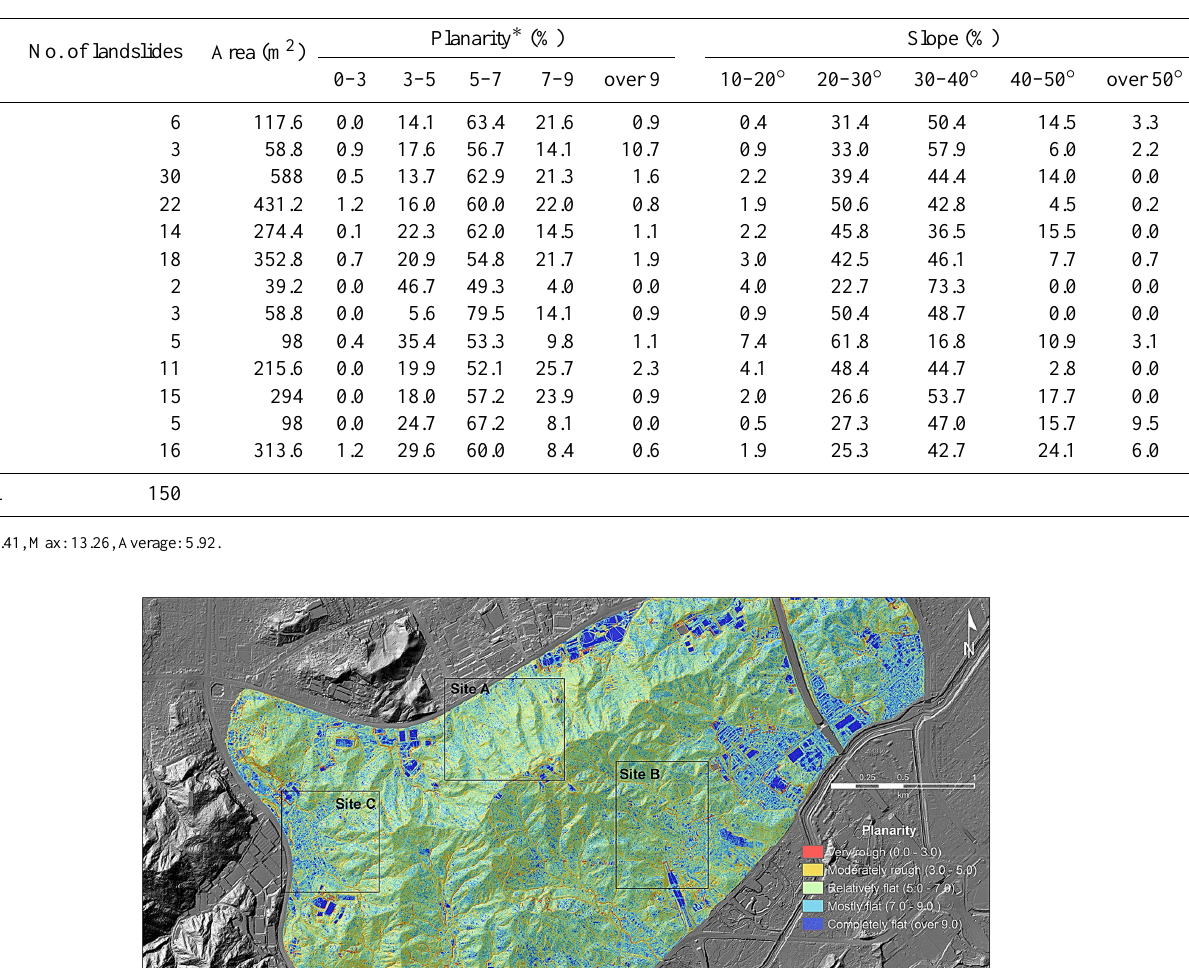
Table 3. Distribution of planarity and corresponding slope values in the study area.